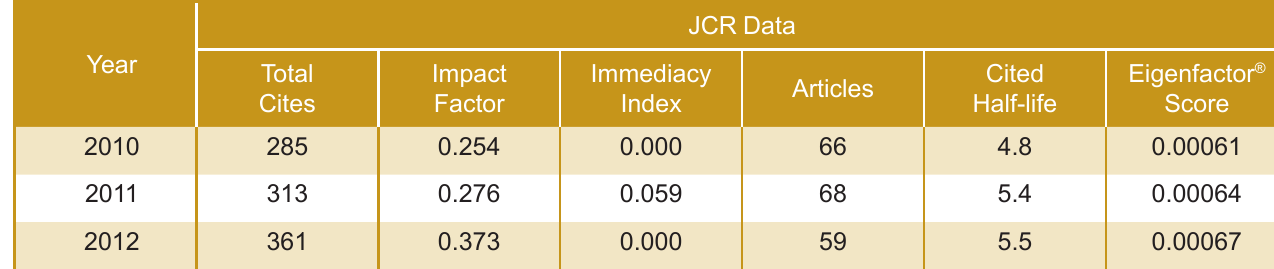
TABLE I - Impact fator